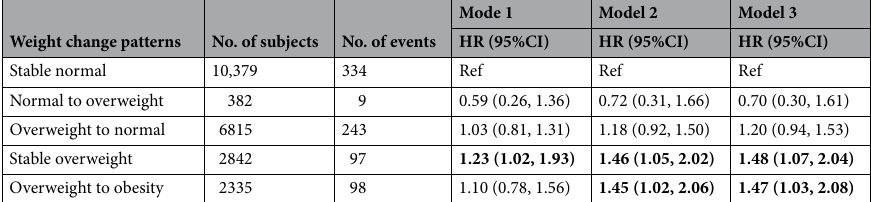
Table 4. Hazard ratios (HRs) and 95% confidence intervals (CIs) of incident asthma with participants with overweight at age 25 or 10 years before baseline in NHANES 2001–2018. All estimates accounted for complex survey designs and the analyses used the sample weights, stratification and clustering suggested by the CDC. Significant results are in boldface type. Model 1: Non-adjusted model. Model 2: Adjusted for age at 10 years before baseline, sex, race/ethnicity. Model 3: Adjusted for age at 10 years before baseline, sex, race/ethnicity, baseline education level, baseline family income, baseline smoking status.